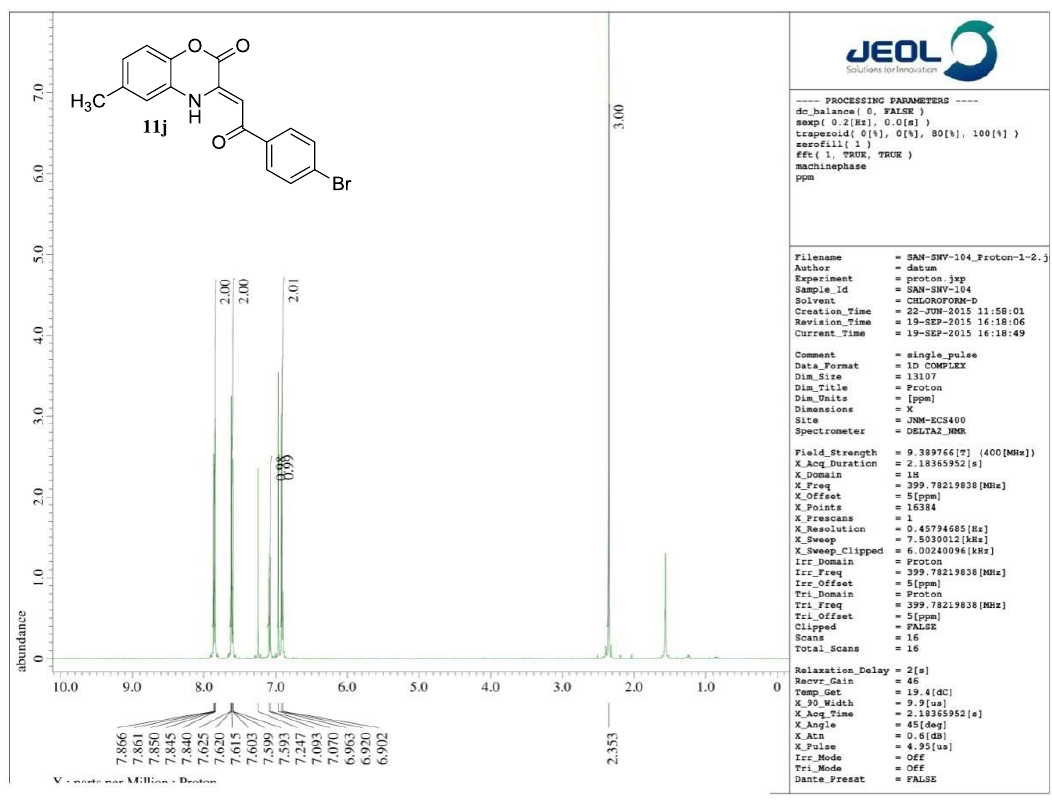
Figure 19. 1 H NMR Spectra of Compound 11j.